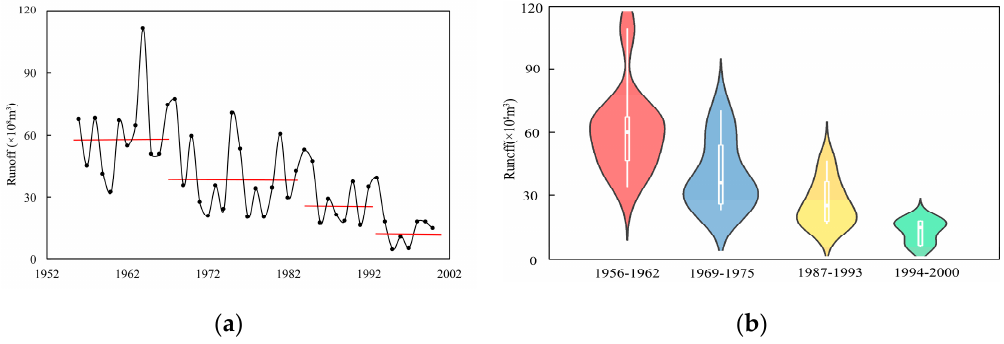
Figure 6. Segmentation of runoff series and their violin figures at Xianyang gauge. (a) the runoff series of each segment; (b) the violin figures of each segment.